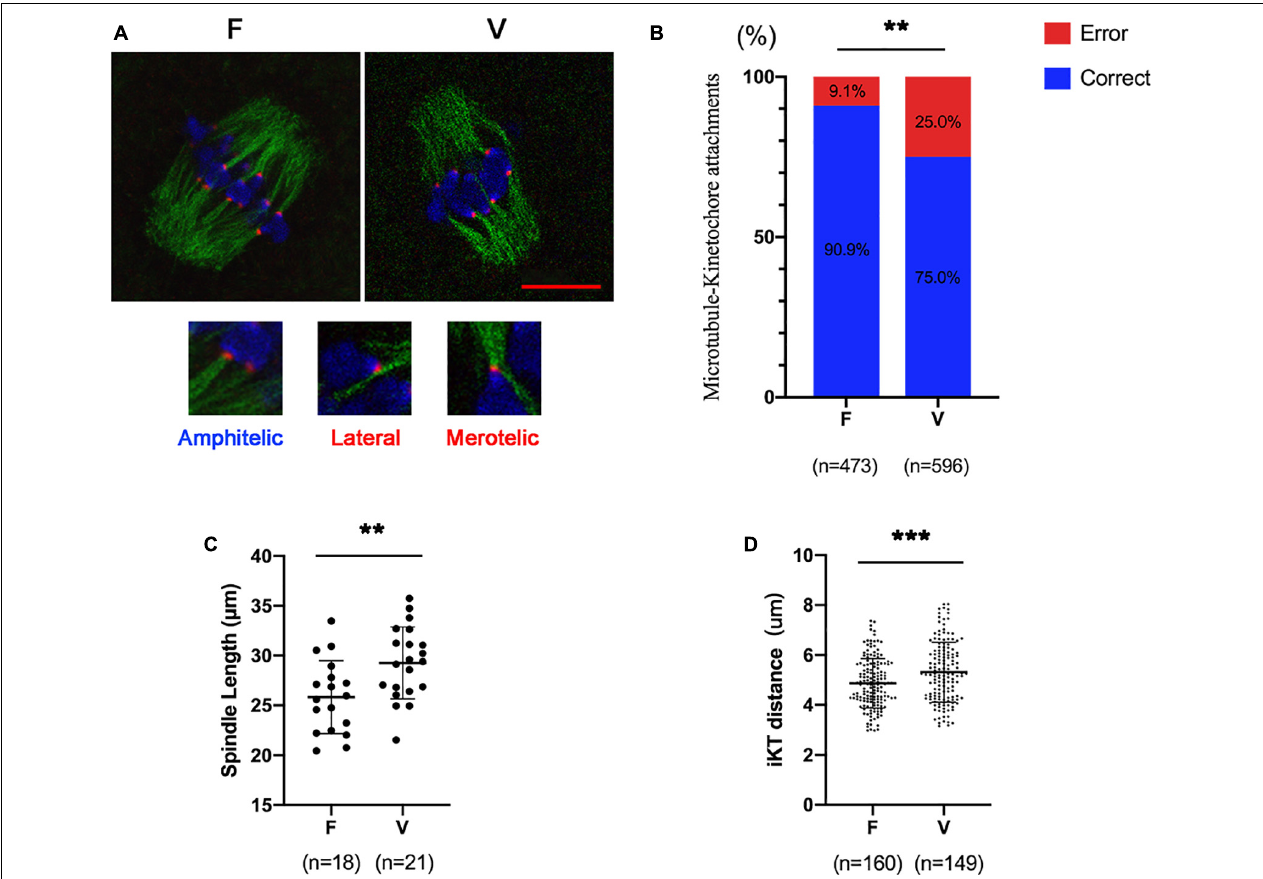
FIGURE 1 | The incorrect KT-MTs were increased in vitrified oocytes. (A) Oocytes were fixed at 6h after GVBD to detect kinetochores (red), microtubules (green), and chromosomes (blue). The representative KT-MTs were shown in magnified images, such as correct attachments (end-on amphitelic attachments) and incorrect attachments (one kinetochore attached two microtubules from the opposite spindle polar or a kinetochore attached to the lateral side of microtubule). Scale bar: 10 µ m. (B) The rate of incorrect KT-MTs was quantified in F and V groups, respectively. The rate of incorrect KT-MTs was significantly increased in vitrified oocytes. F: n = 473; V: n = 596; n : the number of the KT-MT attachments. (C) The spindle length in F and V groups were quantified, respectively. F: n = 18; V: n = 21; n : the number of oocytes. (D) The distance of kinetochores on each bivalent was measured. F: n = 160; V: n = 149, n : the number of bivalent. The experiments were replicated three